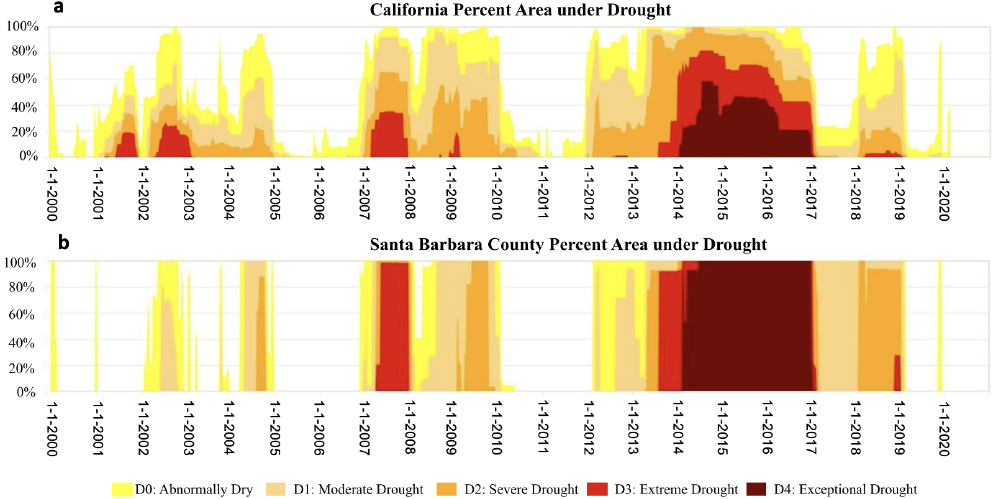
Figure 2. Time series of (a) percentage area of California under drought and (b) percentage area of Santa Barbara County under drought. (The US Drought Monitor is jointly produced by the National Drought Mitigation Center at the University of Nebraska Lincoln, the United States Department of Agriculture, and the National Oceanic and Atmospheric Administration. Map courtesy of